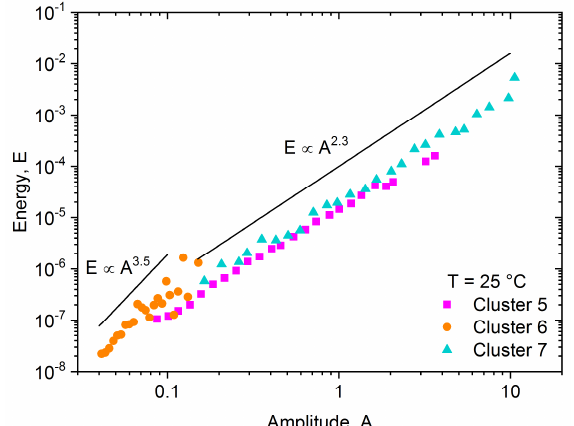
Figure 5. The average PSD functions, as the centroids of the clusters, including the number of avalanches at 25 °C.